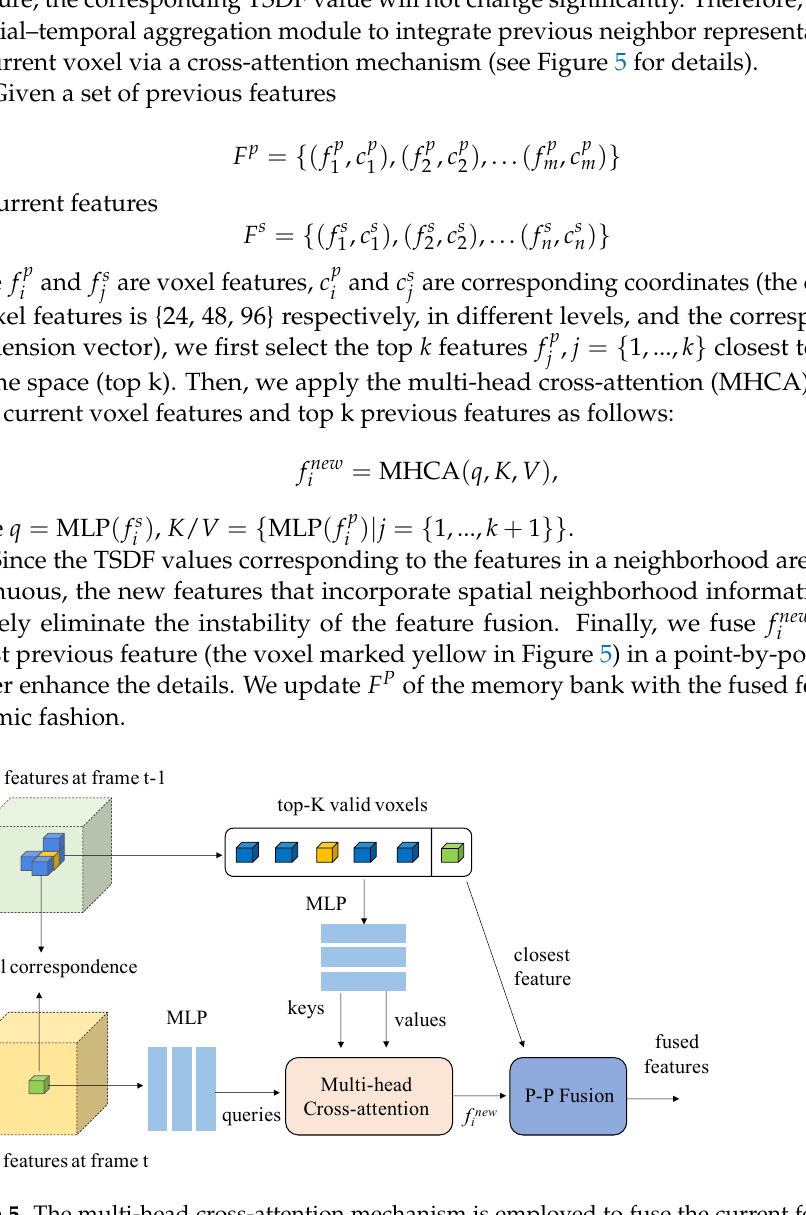
Figure 5. The multi-head cross-attention mechanism is employed to fuse the current feature with previous neighborhood ones. The resulting f new is then fused with the closest feature (yellow voxel) i in a point-by-point fusion